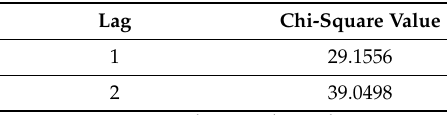
Table A2. Lagrange multiplier